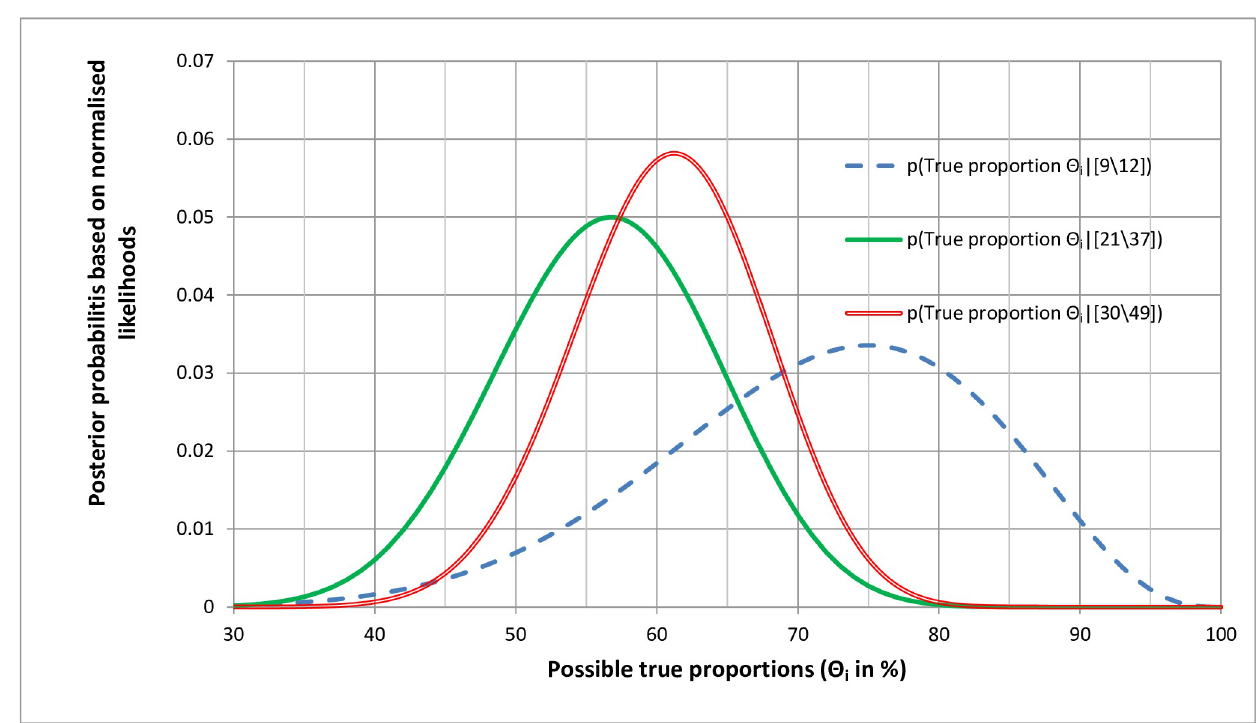
Fig 6. Calculating the posterior probability distribution of true outcomes from a prior probability distribution and a likelihood distribution Θ i .